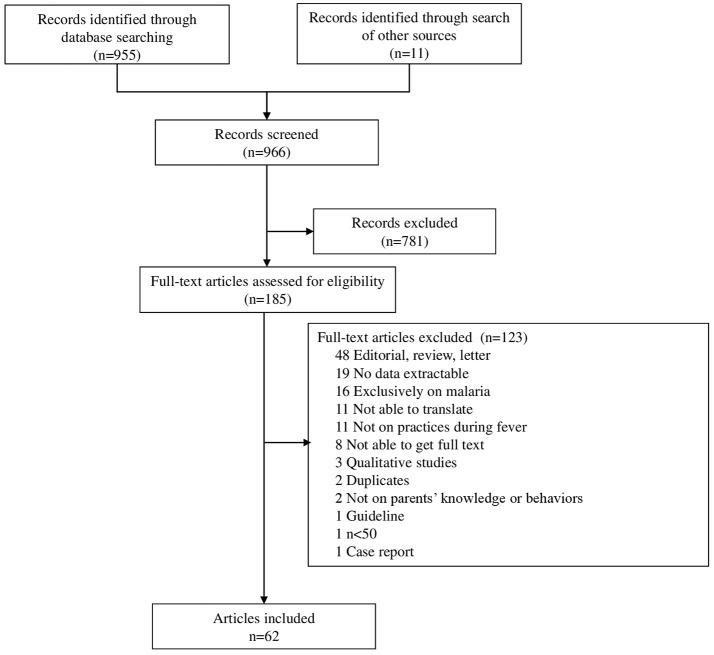
Study flow diagram.